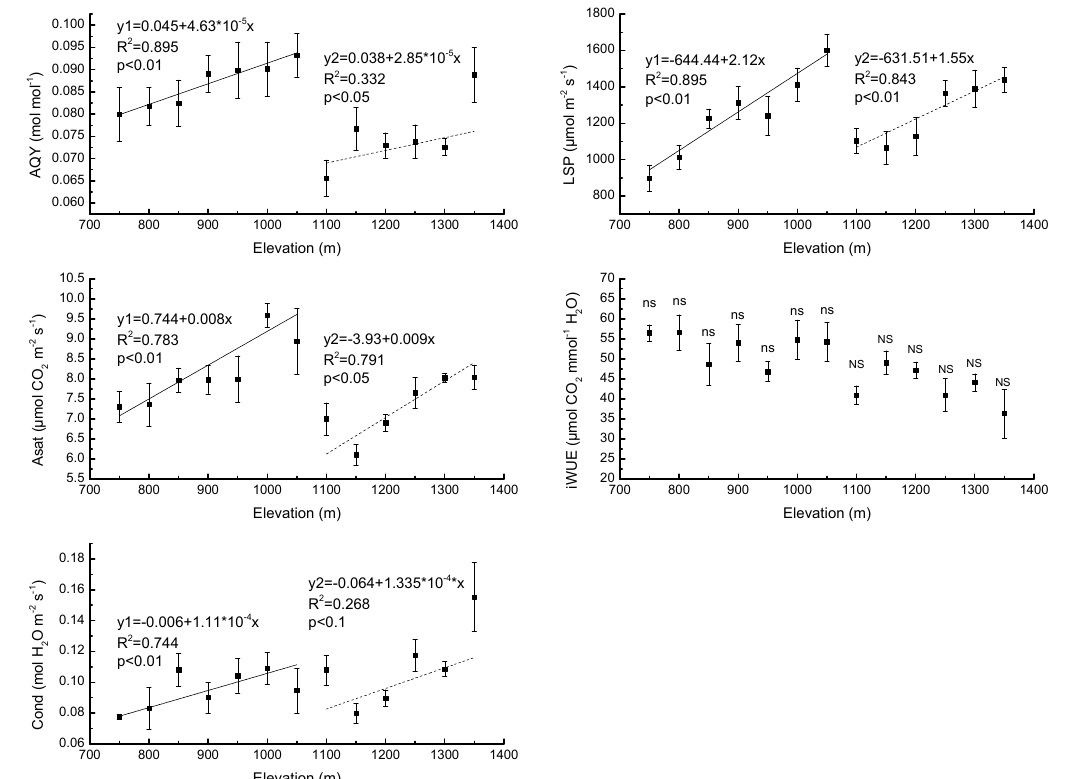
Figure 1. Regression equations of the mean values of apparent quantum yield (AQY), light saturation point (LSP), light saturation net photosynthetic rate (Asat), intrinsic water use efficiency (iWUE) and stomatal conductance (Cond) of needles in Pinus koraiensis Sieb. et Zucc. as a function of elevation on Changbai Mountain. The sample size was 7 for Pinus koraiensis and mixed broadleaved forests (solid lines) and 6 for evergreen coniferous forests (dotted lines). For each elevation, the sample size was 5. The abbreviations “ns” and “NS” mean not statistically significant in PBMF ( Pinus koraiensis and mixed broadleaved forests) and ECF (evergreen coniferous forests), respectively (both at the p < 0.05 level).